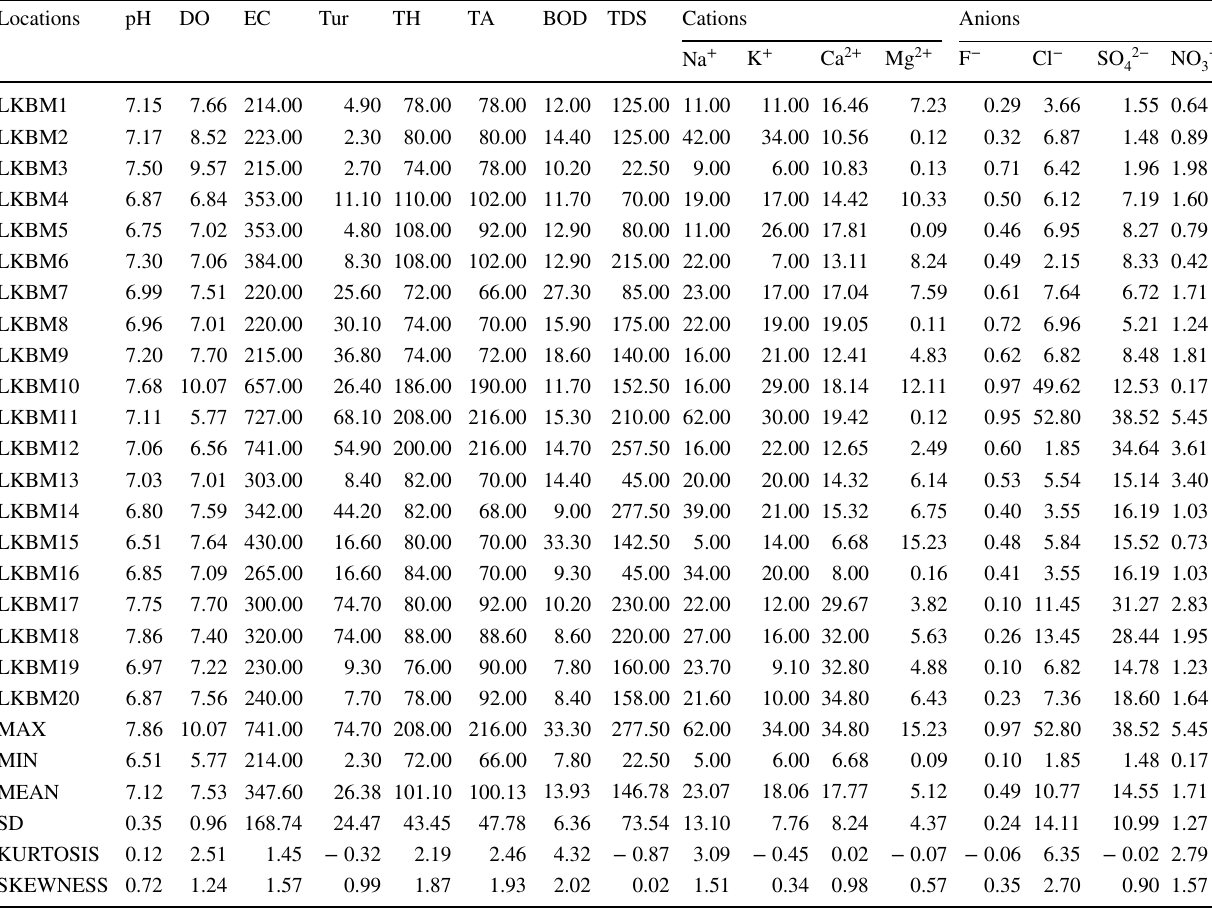
Table 3 Descriptive statistics of physicochemical parameters in pre-monsoon season at North Guwahati Locations